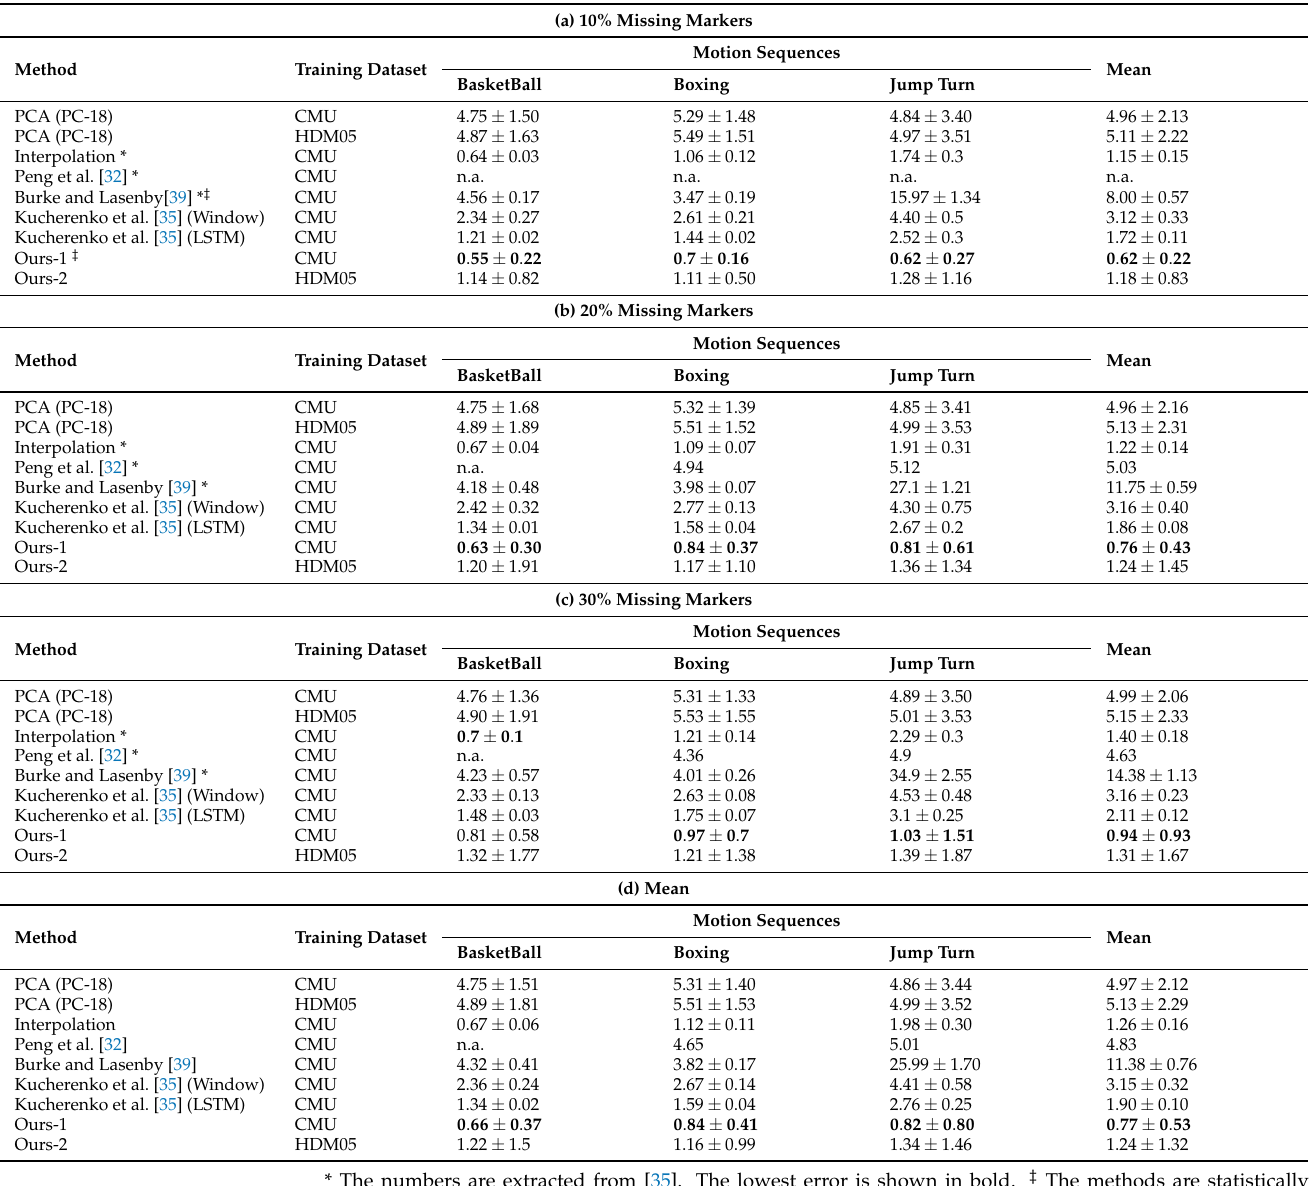
Table 2. Comparison with other state-of-the-art approaches in terms of RMSE over the missing markers of the recovered MoCap sequences. Ours-1 (training: CMU, testing: CMU), Ours-2 (training: HDM05, testing: